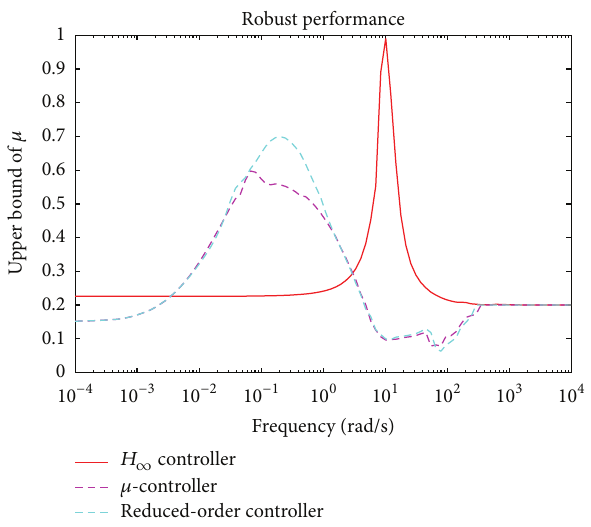
Figure 15: Comparison of robust performance for three controllers.